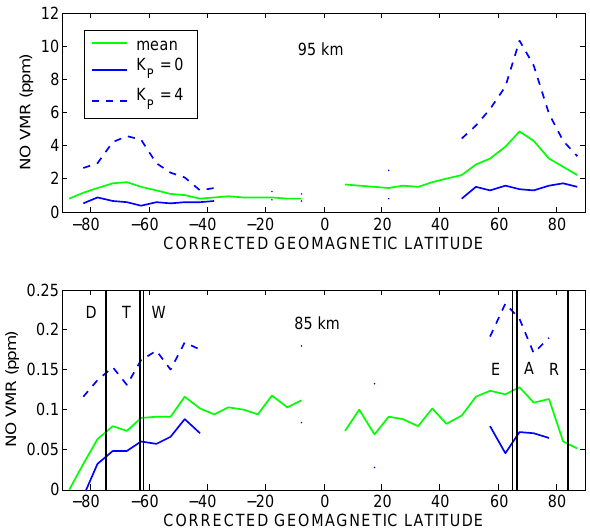
Fig. 10. NO volume mixing ratio, and its sensitivity to geomagnetic disturbance level, from the ODIN-SMR instrument, at two heights, 85km and 95km. NH estimates are for 50 days between 2004 and 2012 during the months June and July. SH estimates are based on days between December 2003 and January 2012 during the months December and January. Zonal means in 5 ◦ bins of corrected geo- magnetic latitude are computed for each day and subsequently av- eraged to find the total mean (green line). Linear regression between the daily zonal means and mean planetary K index ( K P ) for each measurement day are used to find the expected values at K P = 0 (solid blue line)and K P = 4 (dashed blue line). Vertical lines on the lower panel show the corrected geomagnetic latitudes of Davis (D), Wasa (W), Troll (T), Esrange (E), Andenes (A), Resolute Bay